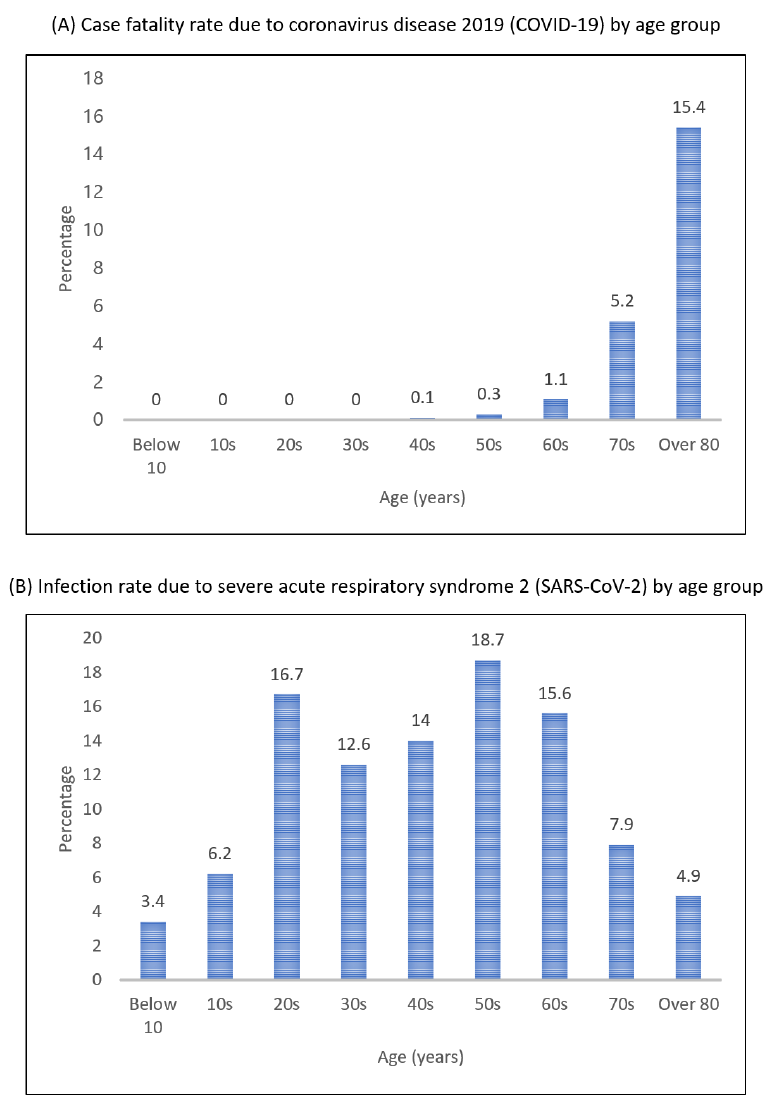
Healthcare 2021 , 9 , x Figure 3. COVID-19 status in South Korea as of 24 December 2020. Figure 3. COVID-19 status in South Korea as of 24 December 2020.